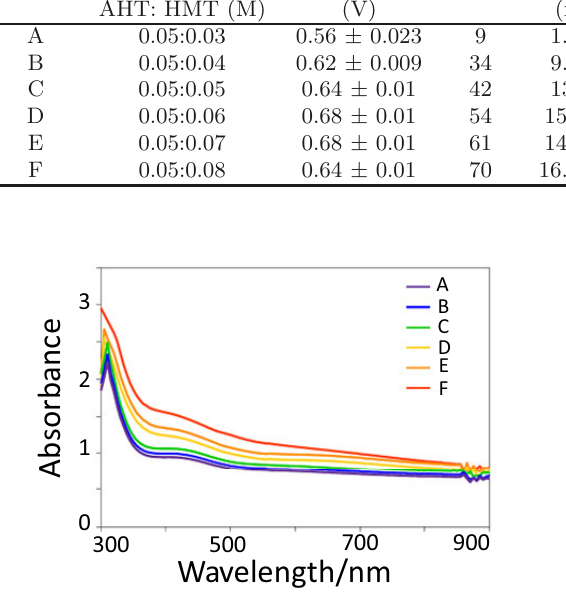
Table 2. Photovoltaic parameter of DSSCs device utilizing TiO 2 nanorice with nanograin size variation. Device